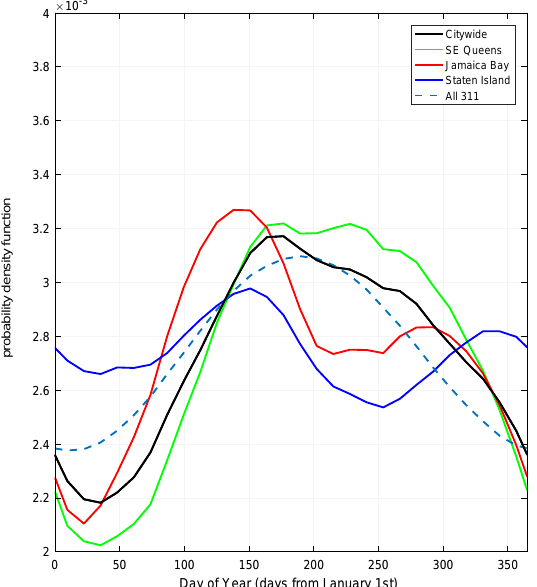
Figure 6. Probability density function for the seasonal variation in 311 reports. “Citywide” represents city-wide flood reports, “Southeast (SE) Queens Jamaica Bay and Staten Island” represent flood reports in these areas (see Figure 2), and “All 311” represents any 311 complaint.